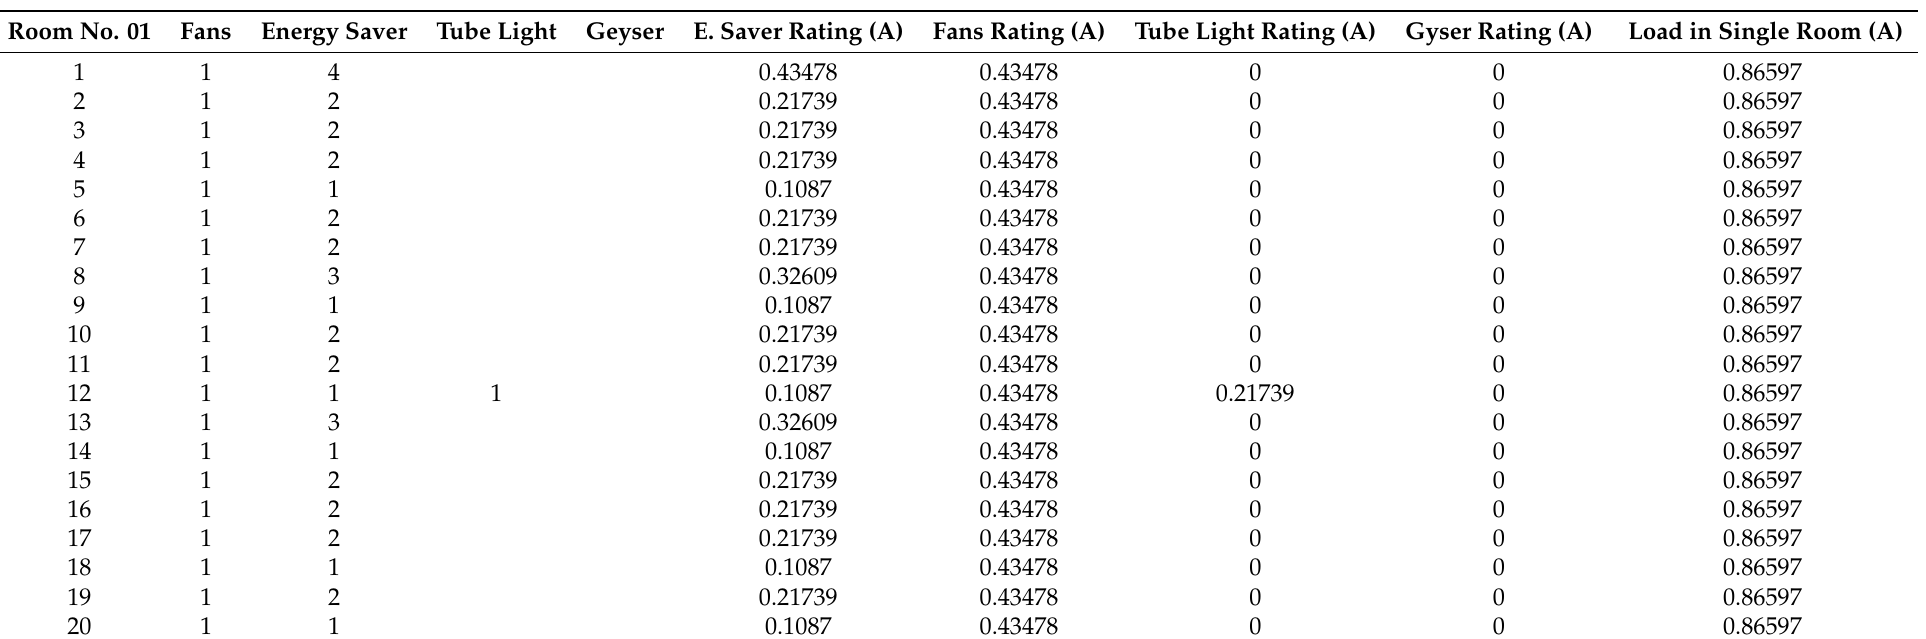
Table 2. Allama Iqbal Hostel existing load